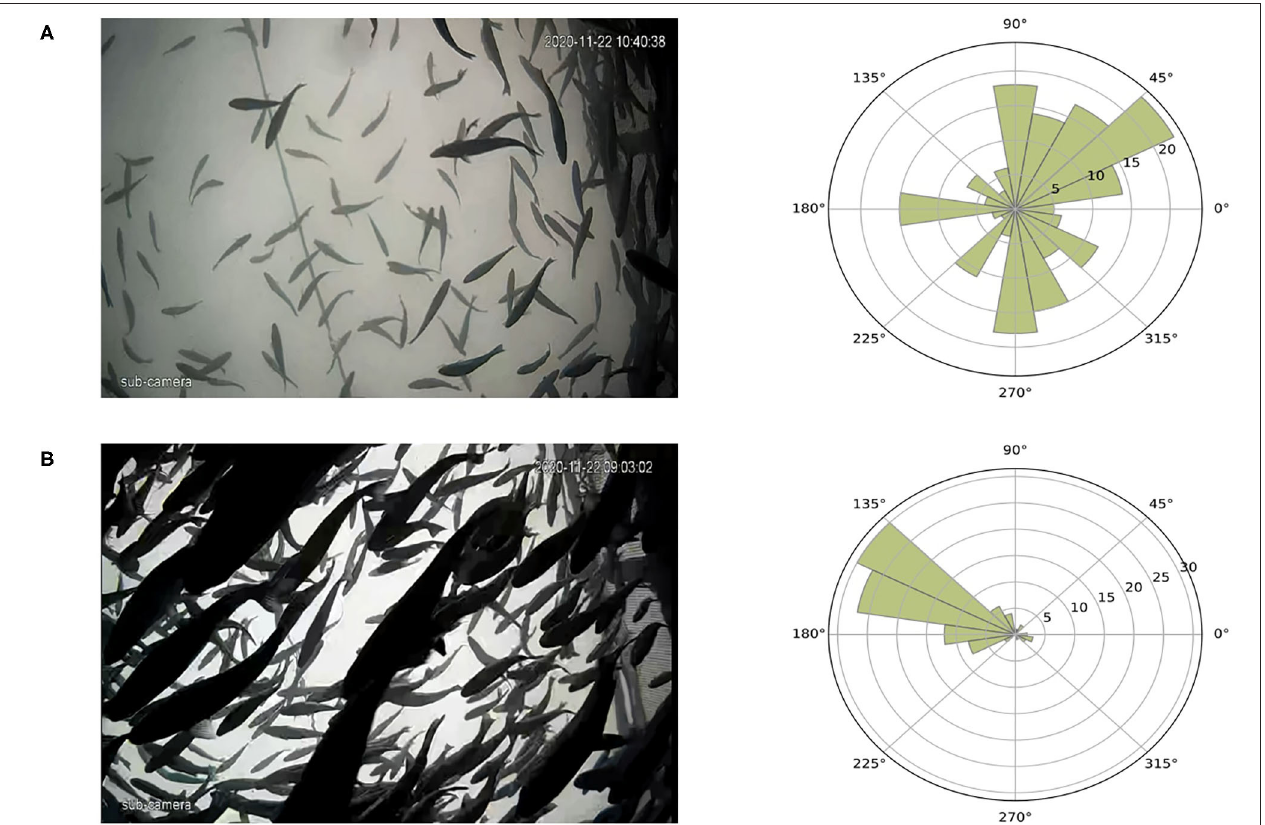
FIGURE 10 | Variations of fish swimming direction according to different motion patterns, an example. (A) Fish swim in an asynchronized way and the rose diagram shows how the angles are distributed. (B) Fish swim in a polarized way during a perceived threat and the spread of the angles is small. The reference system for the image and the rose diagram differs (for images it is clockwise and for the rose diagram it is counter-clockwise).